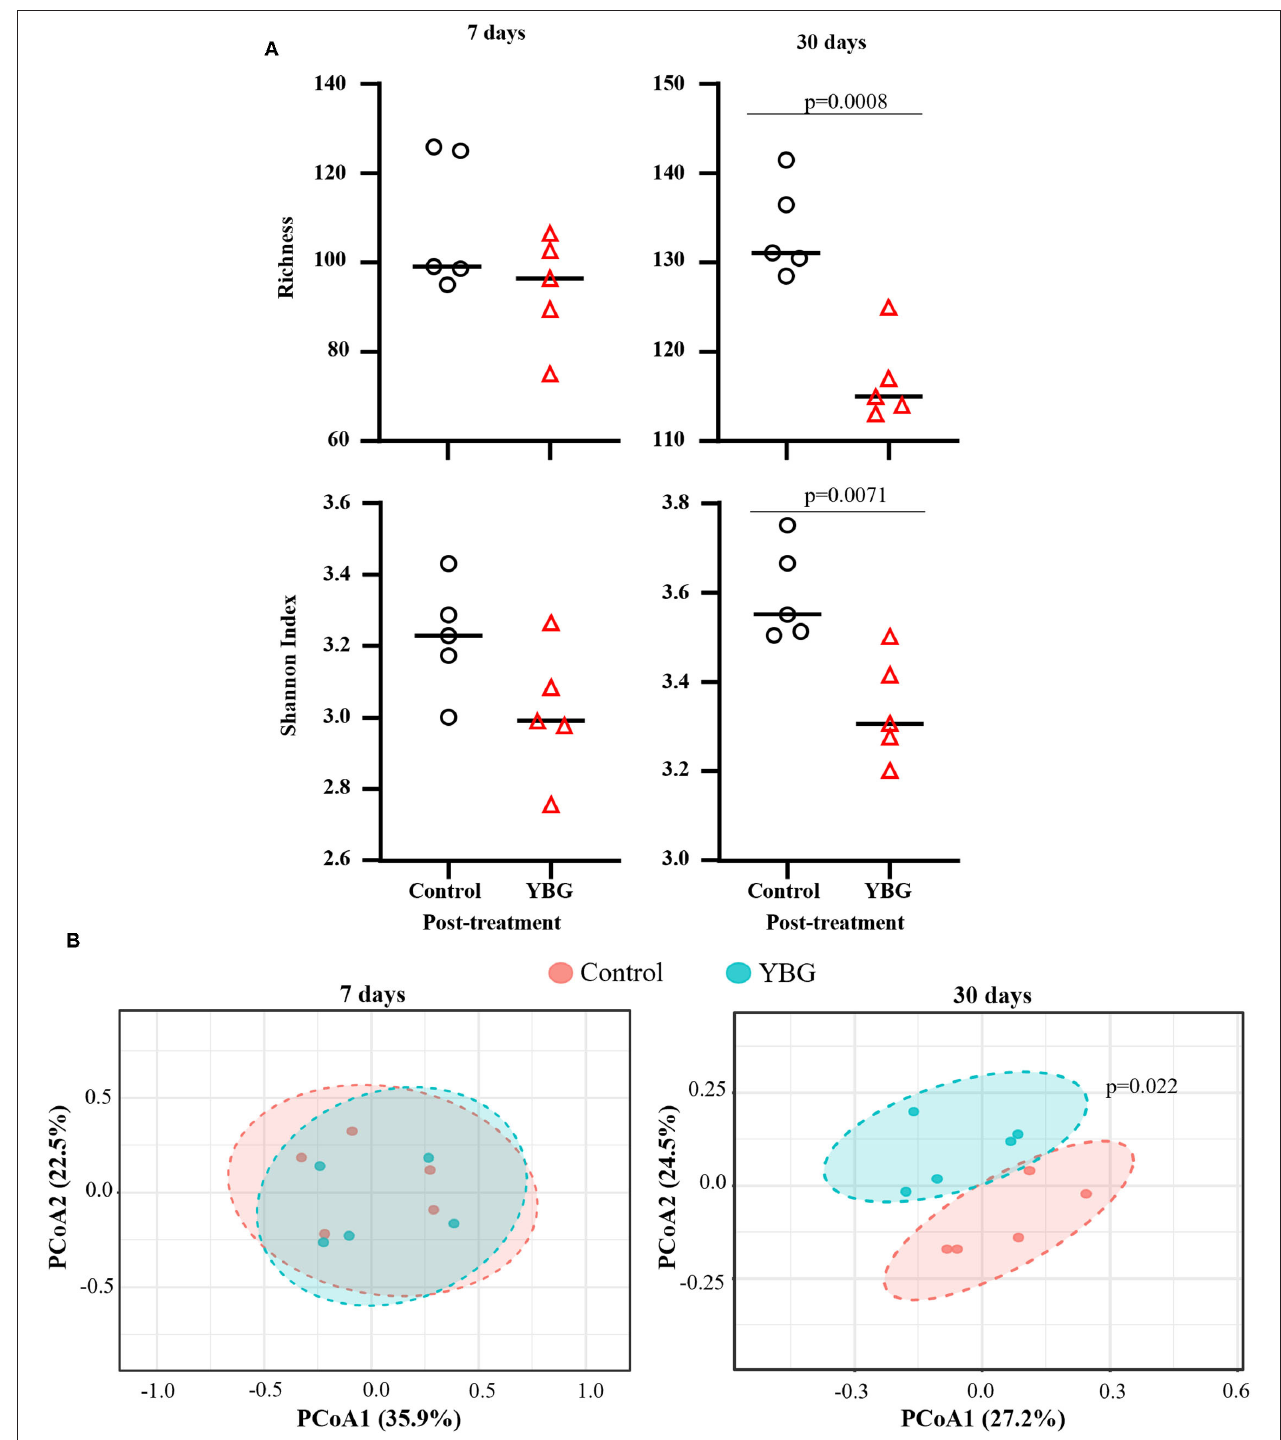
FIGURE 1 | Diversity and community structure of fecal microbiota are significantly altered with 30-day YBG treatment beginning at juvenile age in NOD mice. Two-week-old female NOD mice were given 0.9% saline solution (control) or YBG suspension (100 µ g/day) for 7 or 30 consecutive days via oral gavage. Mice for both control saline and YBG treated groups of each treatment regimen (7 or 30 days) were originated from a single pool of pups. Fecal samples collected after 7 days (5 mice/group) and 30 days (5 mice/group) of YBG treatment were subjected to 16S rRNA gene sequencing and analyzed as described in the section Materials and Methods. α and β diversity analyses were performed on OTU. Biom table of 16S rRNA gene sequencing data of fecal samples collected after the treatment. Richness and diversity (A) were calculated via Chao1 richness estimate (top panel) and Shannon index (bottom panel), respectively. P -values were determined via unpaired t -tests. Diversity between samples was determined via principal coordinate analysis (PCoA) with Bray-Curtis dissimilarity to analyze and compare the community structure between control and YBG groups (B) . Statistical significance was evaluated using PERMANOVA.